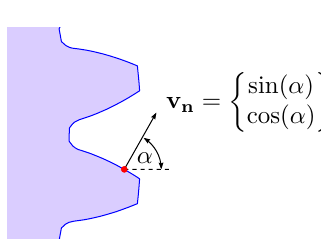
Figure 6: Unit tooth surface normal vector in the pen- etration direction as a function of gear tooth pressure angle α .